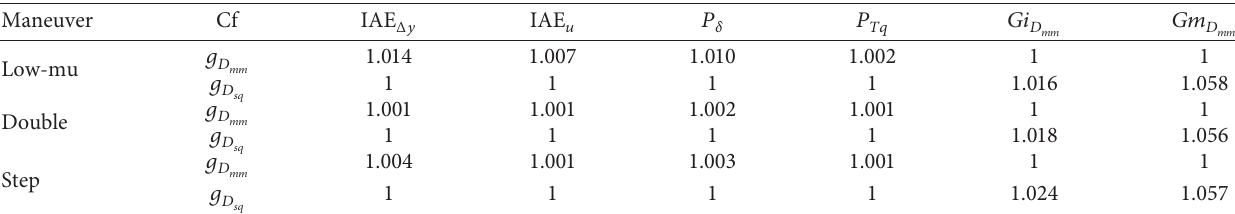
Figure 6: Comparison of the two force-based cost functions on the straight to curve maneuver. (a) Path. (b) Road-wheel angle. (c) Wheel torques of mm. (d) Wheel torques of sq. (e) Longitudinal speed. Table 4: Comparison of the two dissipation-based cost functions performing the test